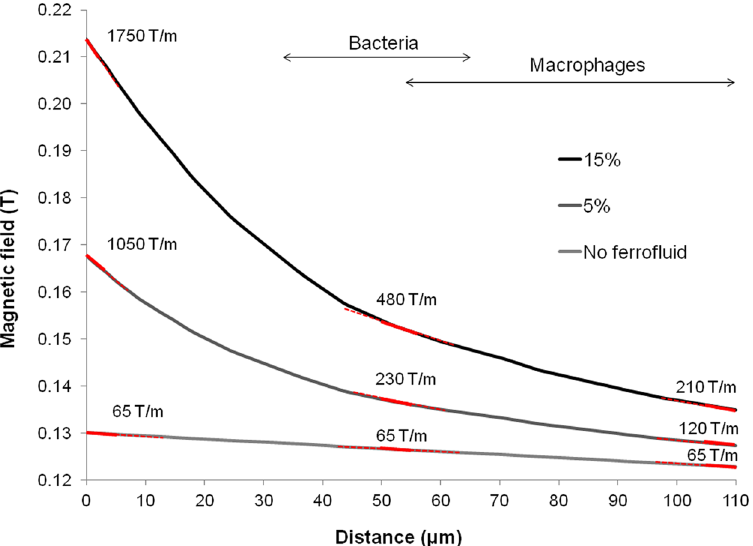
Figure 2. Simulations of the magnetic field in the separation channel. Estimates of the magnetic field intensity in the microfluidic channels were performed using finite elements analysis (FEMM). The graph shows the magnetic field across the sorting channel obtained for different concentrations of a ferrofluid, magnetized by a 40 MGOe NdFeB magnet. The magnetic field gradient is indicated by the red lines at three points within the sorting channel. The arrows indicate the range of distances that the bacterial or mammalian cells were covering when initially introduced into the sorting